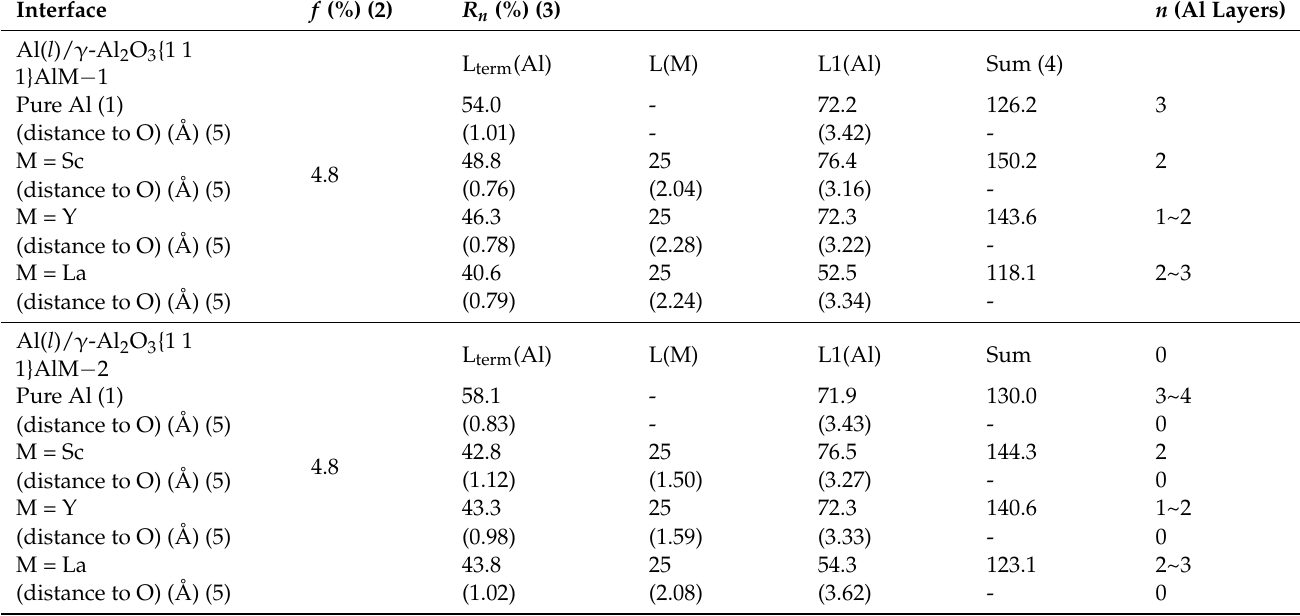
Table 1. Characteristics of the terminating and 1st layers at the Al( l )/ γ -Al 2 O 3 {1 1 1} M interfaces equilibrated at 900